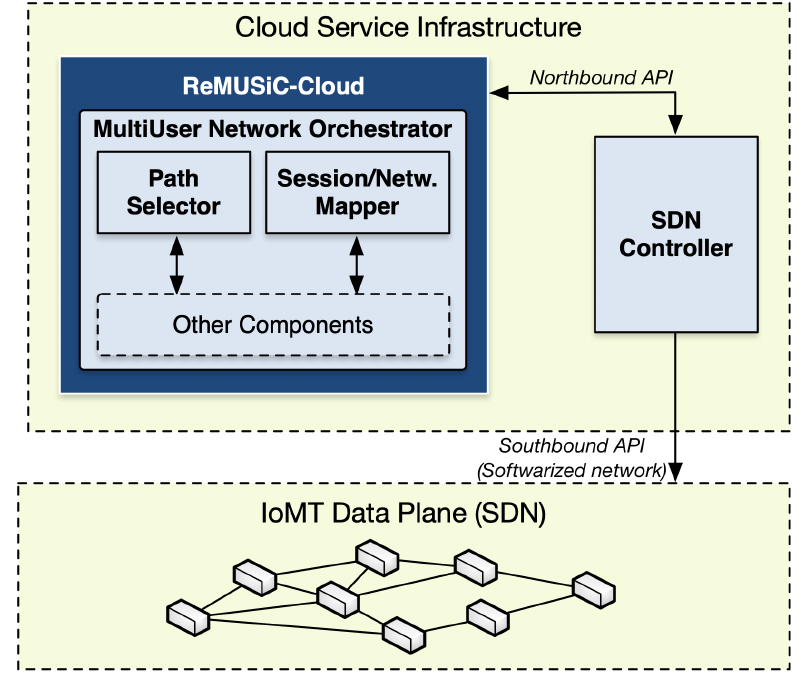
Figure 7. The MultiUser Network Orchestrator (MUNO)